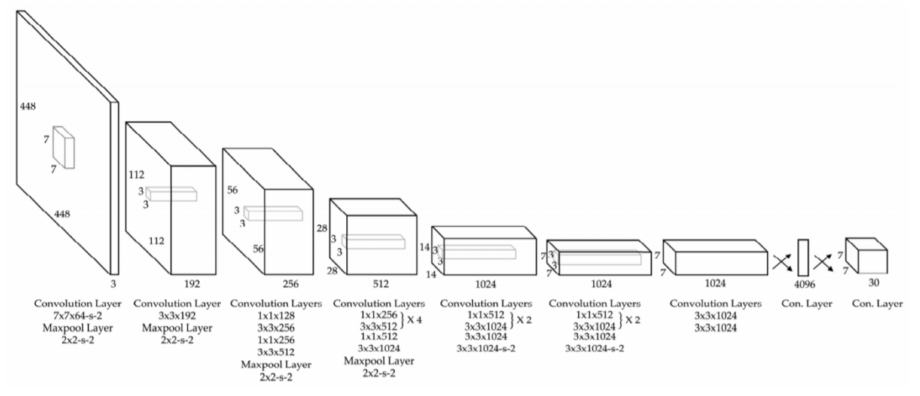
Figure 17. YOLO v3 architecture